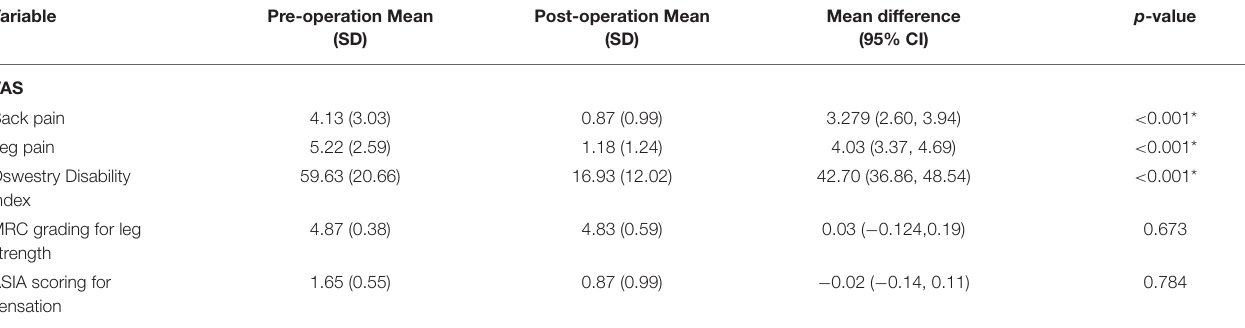
TABLE 2 | Clinical outcome of pain using the visual analog scale (VAS), Oswestry Disability Index (ODI), and motor and sensory function pre- and post-endoscopic surgery.